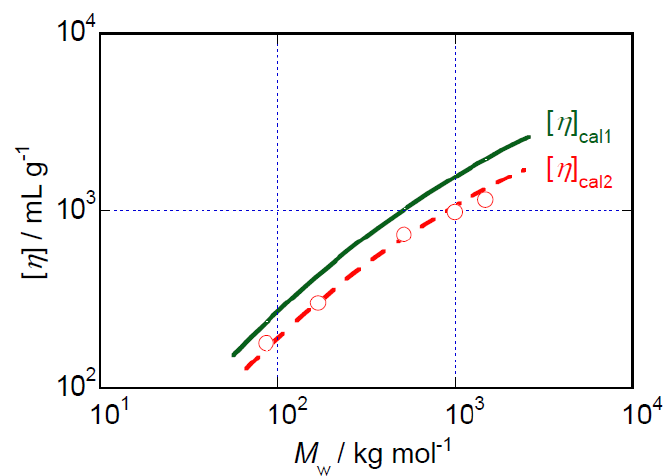
Figure 7. M w dependence of [ η ] data for HeC samples in aqueous solution at 25 °C. The solid line labeled [ η ] cal1 in this figure shows the M w dependence of [ η ] cal assuming the first simple relationship, L η = L and d η = d , and the broken line labeled [ η ] cal2 represents the M w dependence obtained assuming the second relationship, L η = 0.87 L and d η = d .